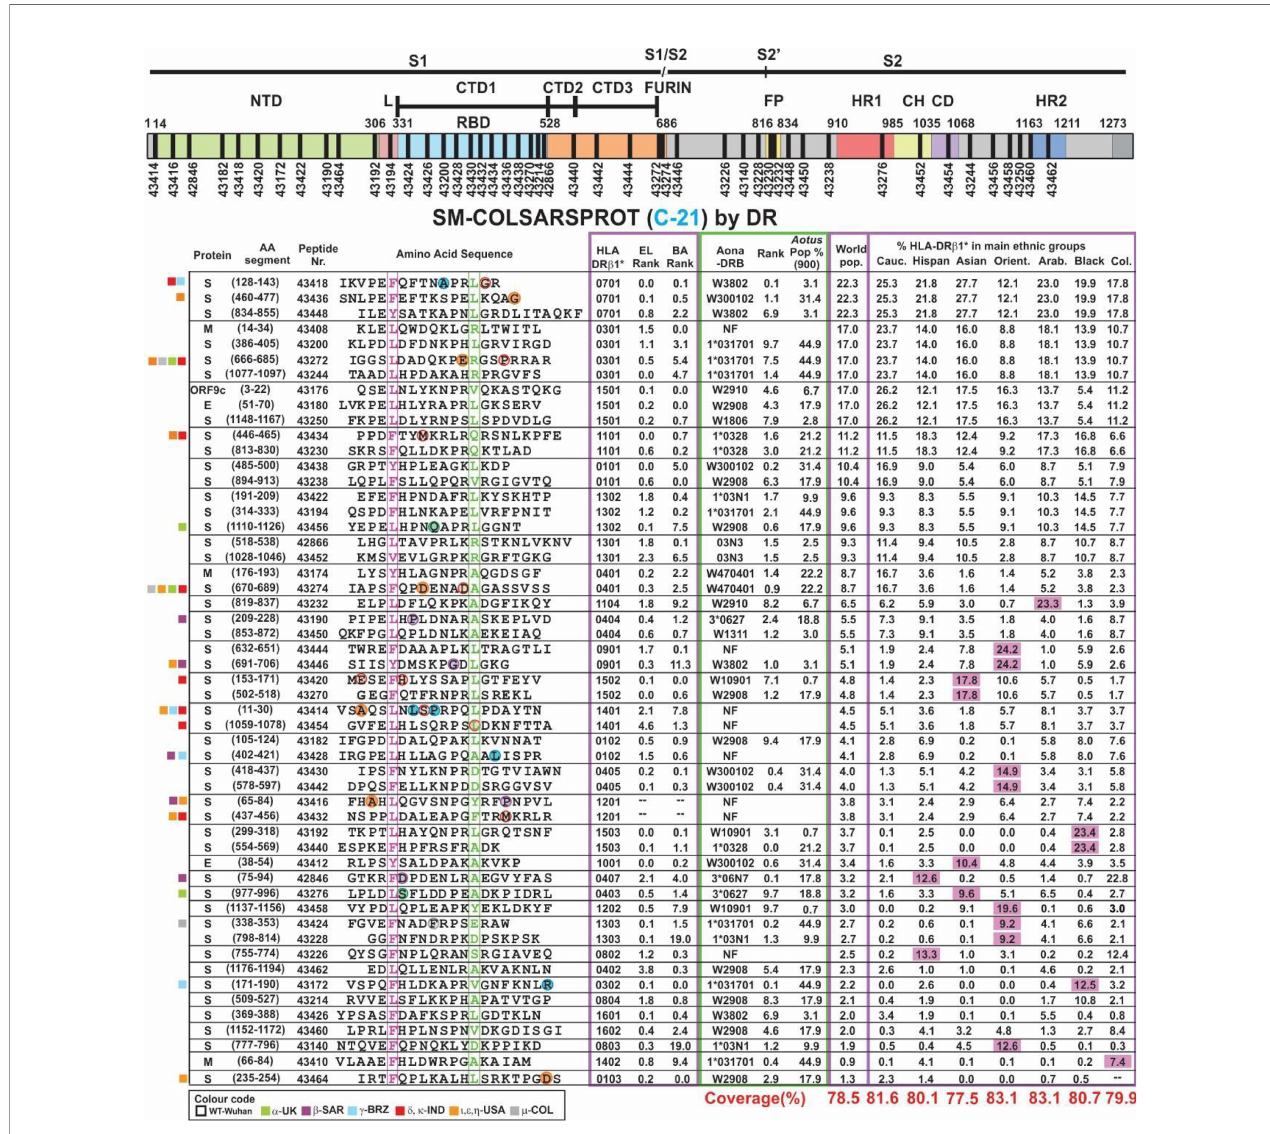
FIGURE 6 | SM-COLSARSPROT modi fi ed peptide aa sequences C21. The same as Figure 3 , but using different peptide numbers representing new modi fi cations in aa sequences and new